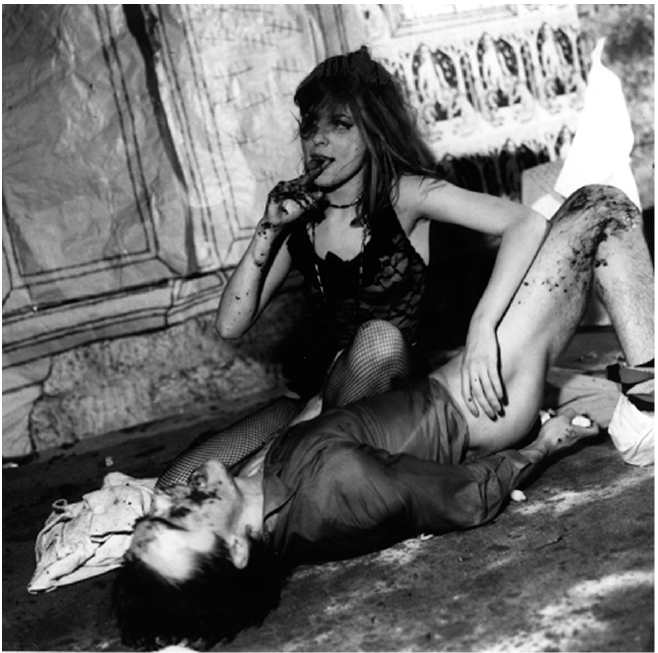
Figure 17. Lisa “Suckdog” Carver and Jean-Louis Costes, La Guerre Civile , performance, 1990. During performances with Suckdog, Costes and Carver would invite women to take to the stage, in chaotic and dynamic interventions, while displaying an unfiltered reality through their treatment of violent and conceptual themes. These artists would subvert the aggressive codes traditionally employed by male performers, in particular when American cartoonist and actress Dame Darcy joined Suckdog for the 1992 “Freak Show” tour; a photograph of the event was used to illustrate the cover of an issue of the Rollerderby fanzine published by Carver (Figure 18) at the time 26